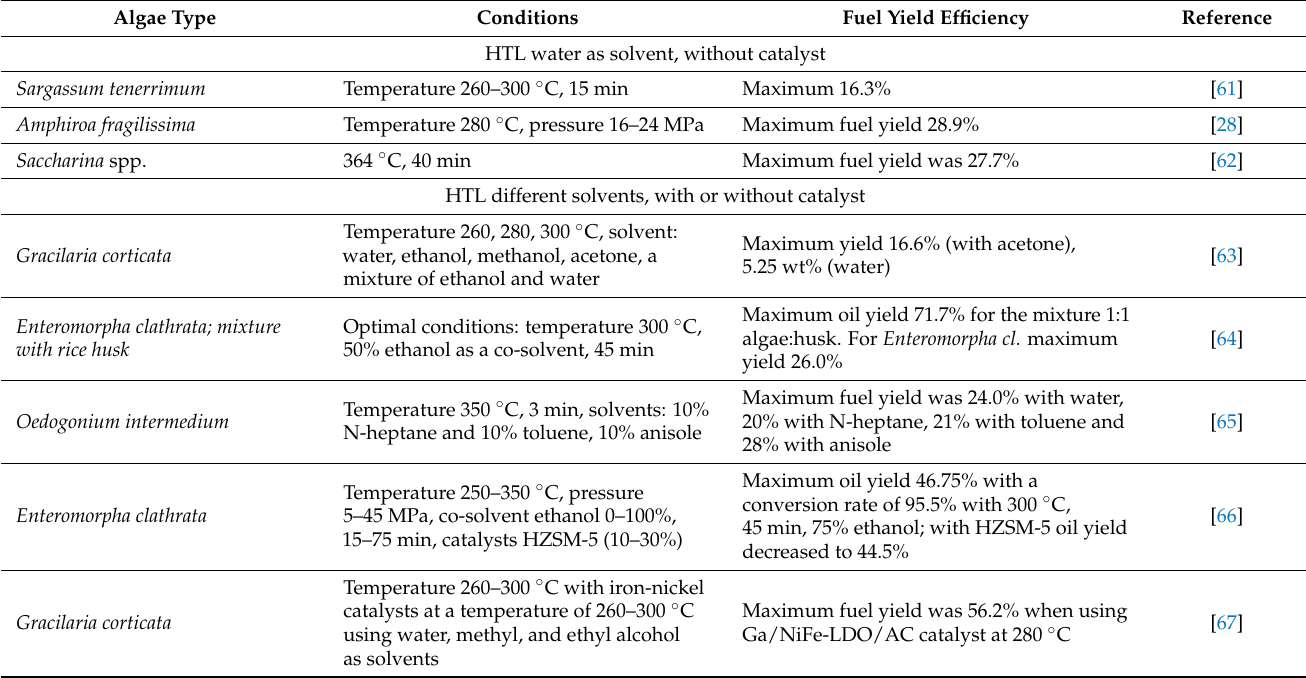
Table 2. Results of hydrothermal liquefaction of